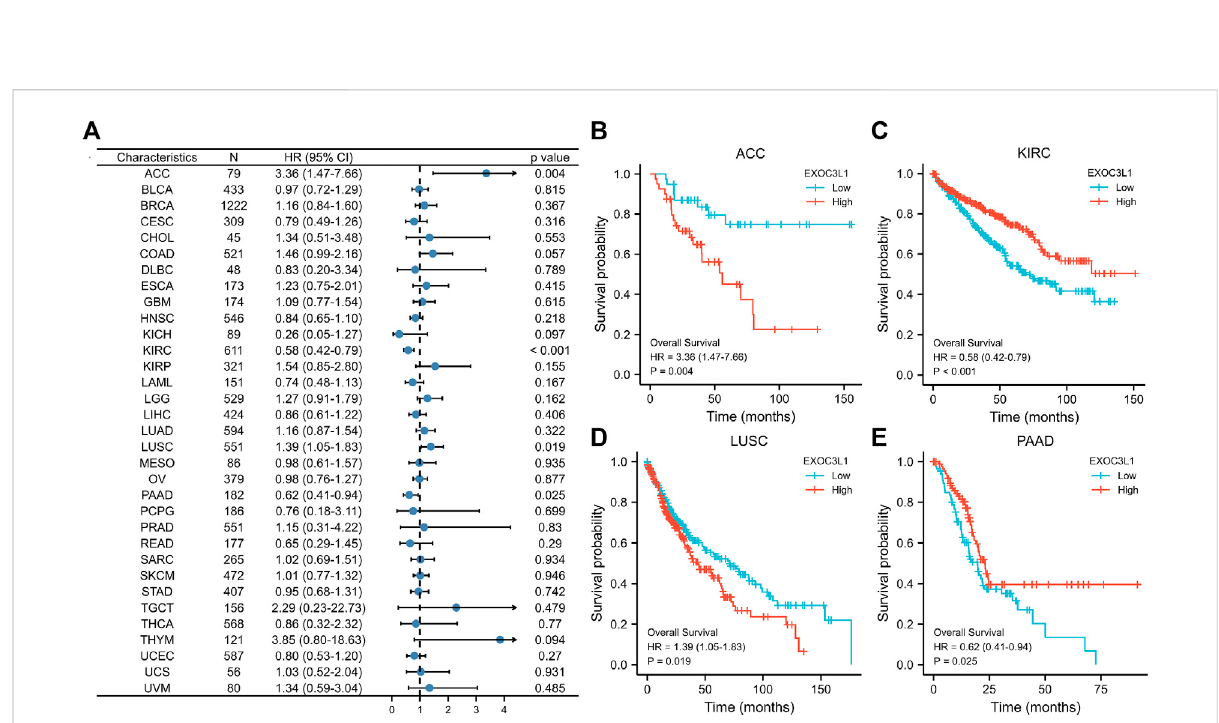
FIGURE 3 The association between EXOC3L1 expression and OS in pan-cancer. (A) The effects of EXOC3L1 expression on OS in pan-cancer were exhibited by a forest plot. (B – E) Effects of EXOC3L1 expression on OS in ACC, KIRC, LUSC and PAAD,